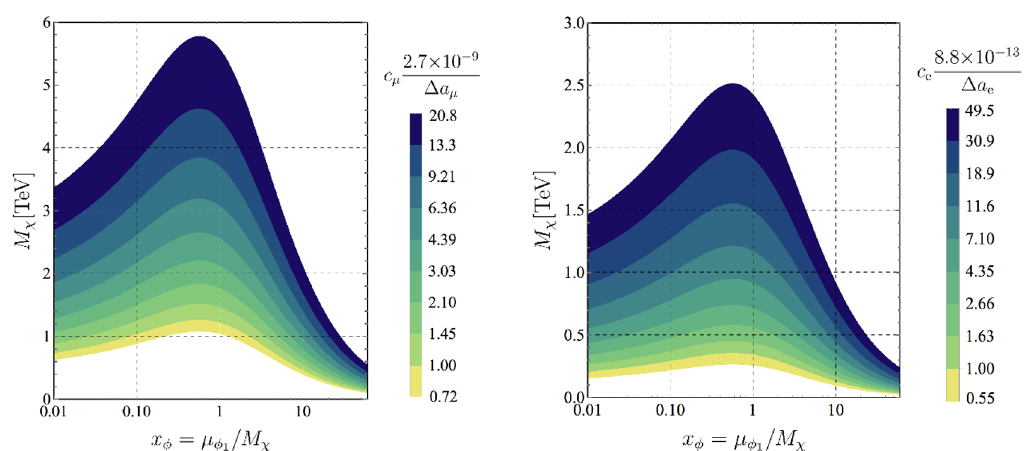
Figure 3 . Mediator mass M (cid:31) as function of x (cid:30) for the muon case (left panel) and the electron case (right panel). We have used eq. (2.9) imposing (cid:1) a exp